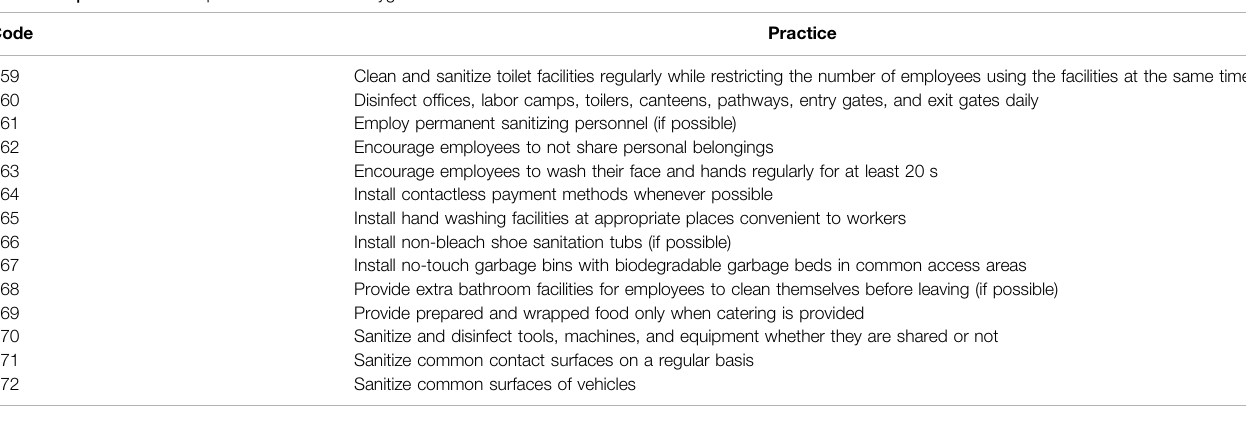
TABLE 10 | Recommended practices to maintain hygiene.